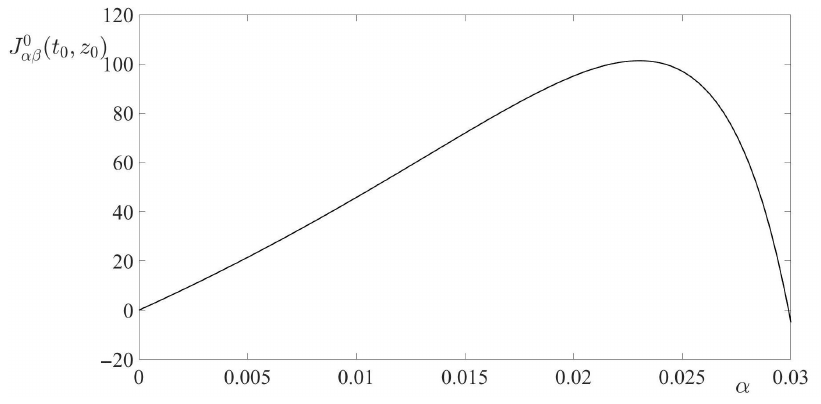
Figure 8. Time realizations v 0 The game value J 0 tended to zero for α → 0.